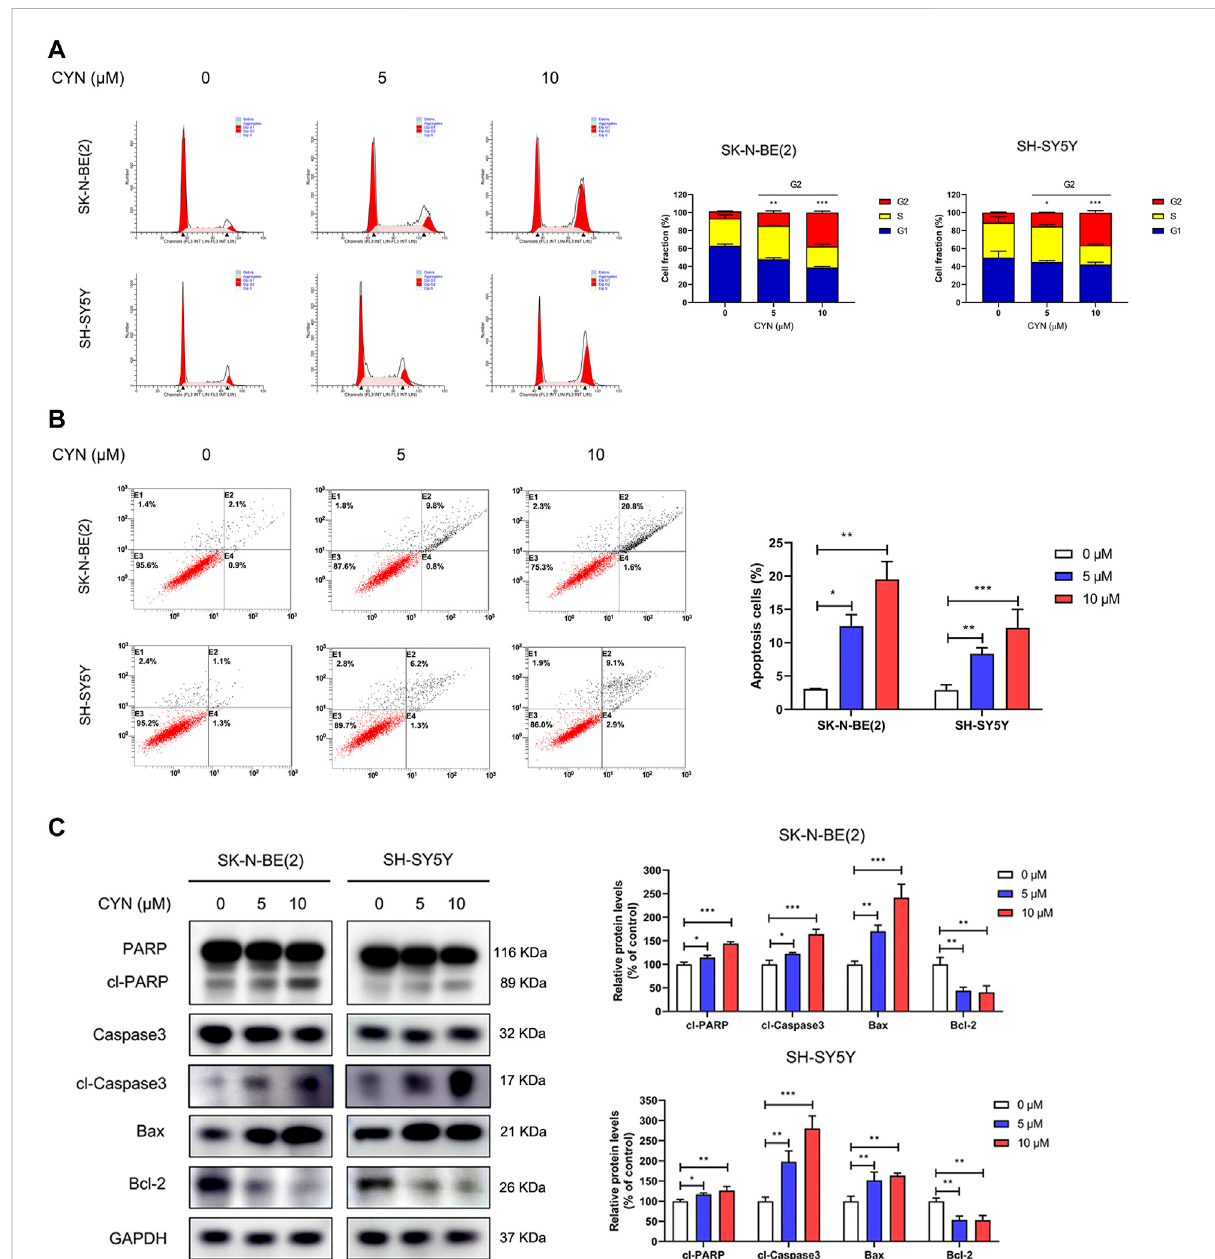
FIGURE 2 EffectsofCYNonthecellcycleandapoptosisinNBcells. (A) Cellcyclewasanalyzedby fl owcytometry. (B) AnnexinV-FITC/PIstainingand fl ow cytometry were used to measure and analyze apoptotic NB cells treated with CYN for 24 h. (C) The expression levels of apoptosis markers were measured by western blot analysis. * p < 0.05, ** p < 0.01, *** p < 0.001 versus the control